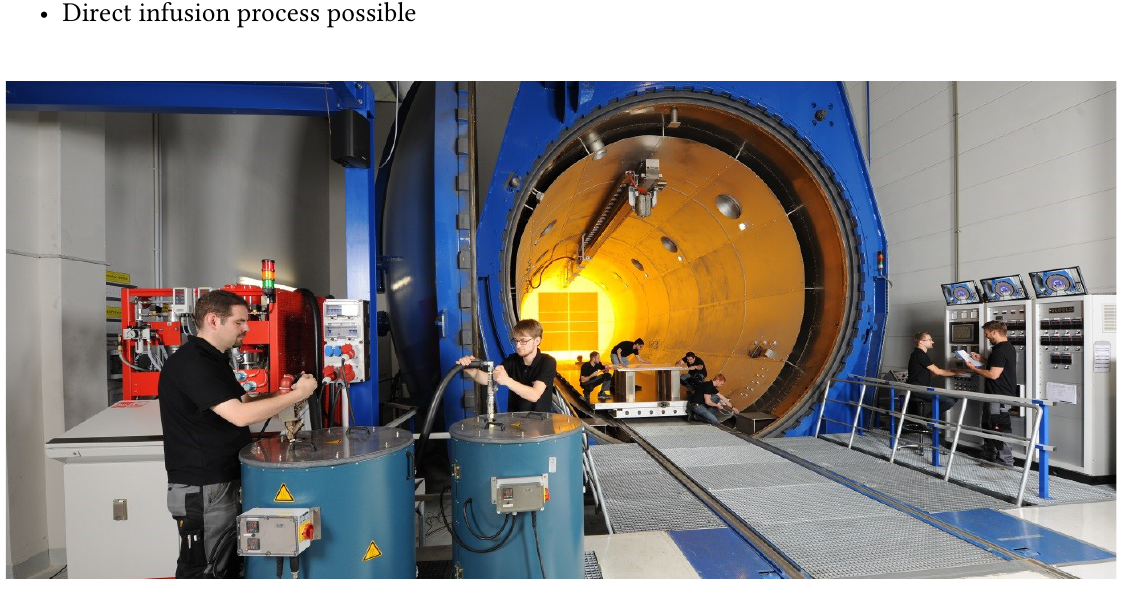
Figure 3: Infusion plant